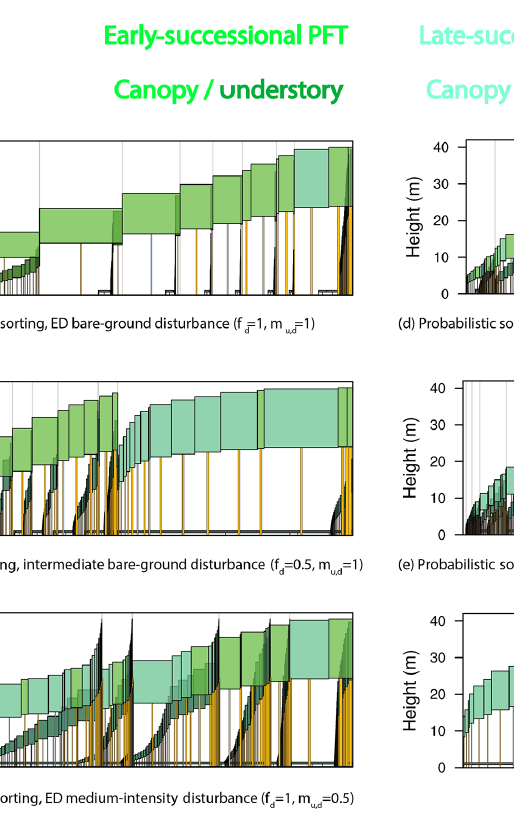
Figure 15. Forest structure and composition at year 600 of one ensemble member for each structural sensitivity experiment. Experiments are as in Figs. 13–14 and ordered from most promoting of early-successional to late-successional PFTs: (a) deterministic sorting, pure- ED, bare-ground ( f d = 1, m u , d = 1) disturbance; (b) deterministic sorting, intermediate bare-ground disturbance; (c) deterministic sorting, pure-ED medium-intensity ( f d = 1, m u , d = 0 . 5) disturbance; (d) probabilistic sorting ( c excl = 3), intermediate bare-ground disturbance; (e) probabilistic sorting ( c excl = 1), intermediate bare-ground disturbance; and (f) deterministic sorting, pure-PPA ( f d = 0) disturbance. The same ensemble member was used for each panel so that plant traits are identical across experiments. Each panel depicts individual cohorts, arranged from tallest to shortest within a patch from right to left. The horizontal axis of each panel shows area: both cohort crown area and patch area. Older patches are to the right, with thin vertical lines separating patches. Cohort widths in the figure are proportional to the crown area of each cohort. Within the canopy, different PFTs are given different colors, with an early-successional PFT in light green and a late-successional PFT in blue–green. Understory cohorts are shaded darker than canopy